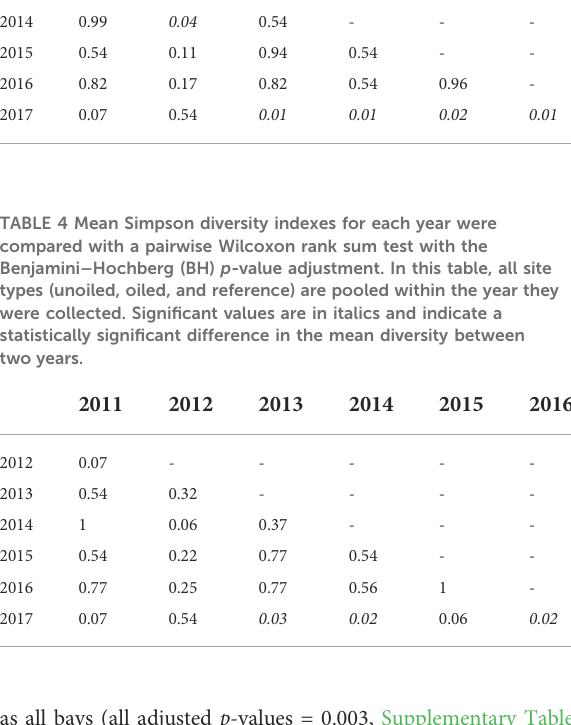
as all bays (all adjusted p -values = 0.003, Supplementary Table